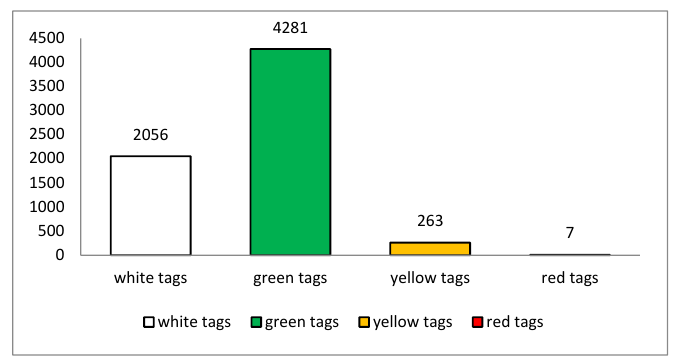
Figure 2. Reported the distributions of the triage tags.